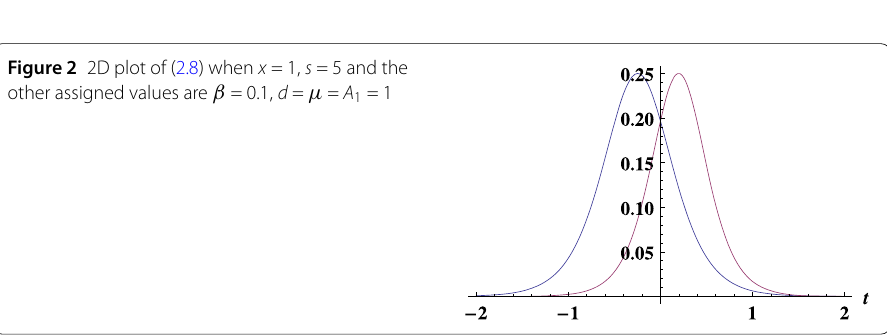
Figure 2 2D plot of (2.8) when x = 1, s = 5 and the other assigned values are β = 0.1, d = μ = A 1 =